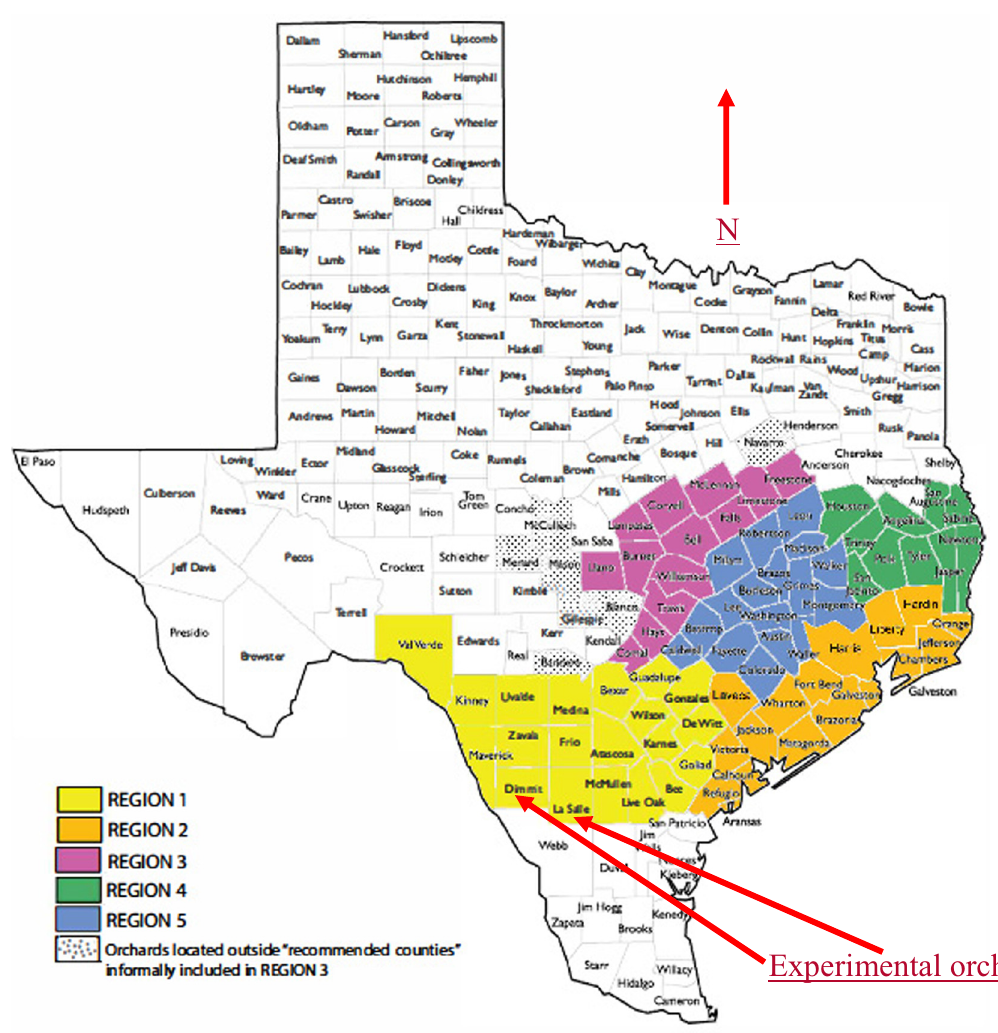
Figure 1: Texas Olive Growing Regions ( Texas Association of Olive Oil 2021 ) . Experimental orchards were located in Texas Olive Growing Region 1. Experimental orchards 1 and 2 were located in Dimmitt County, and experimental orchard 3 was located in La Salle County,